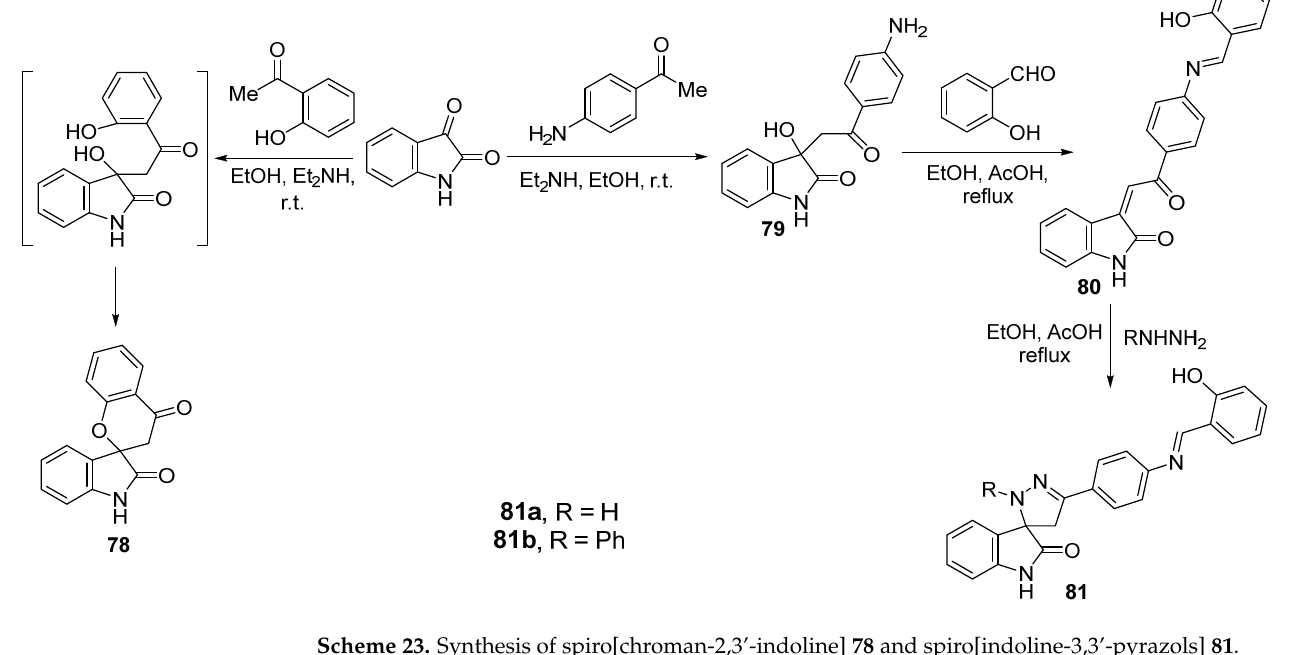
[45]. Scheme 23. Synthesis of spiro[chroman-2,3’-indoline] 78 and spiro[indoline-3,3’-pyrazols] 81 .